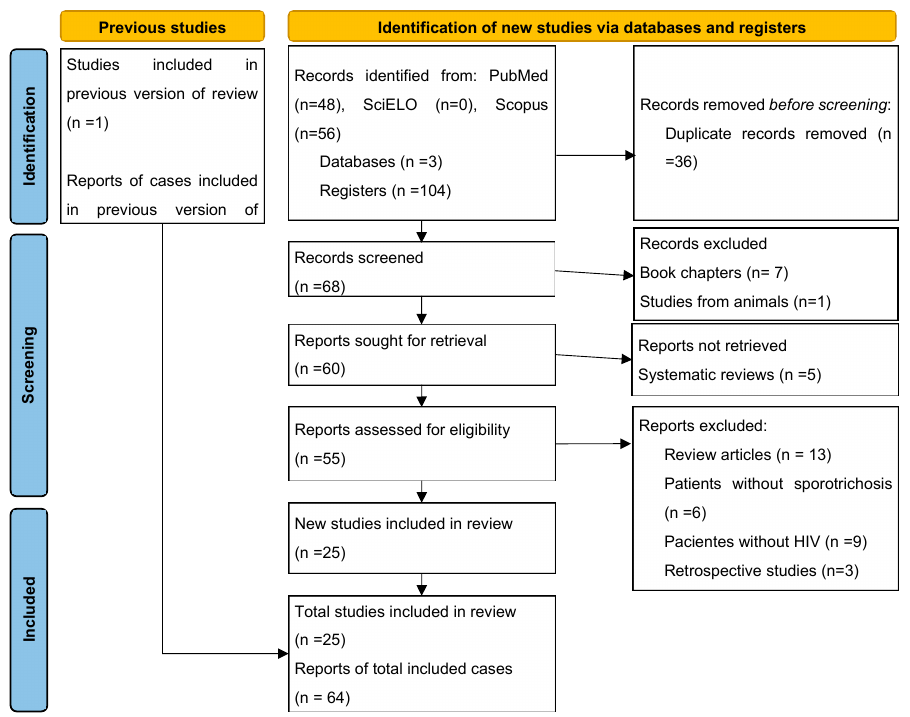
Figure 2. PRISMA flow diagram of data extracted from bibliographic searches. Eligible articles were considered those that described sporotrichosis in patients in- fected with HIV-AIDS, as well as case series. Articles that were reviews from literature, retrospective studies outside the proposed limit, cohort studies, studies of patients with sporotrichosis, but who did not have HIV-AIDS, studies of patients with HIV-AIDS with-